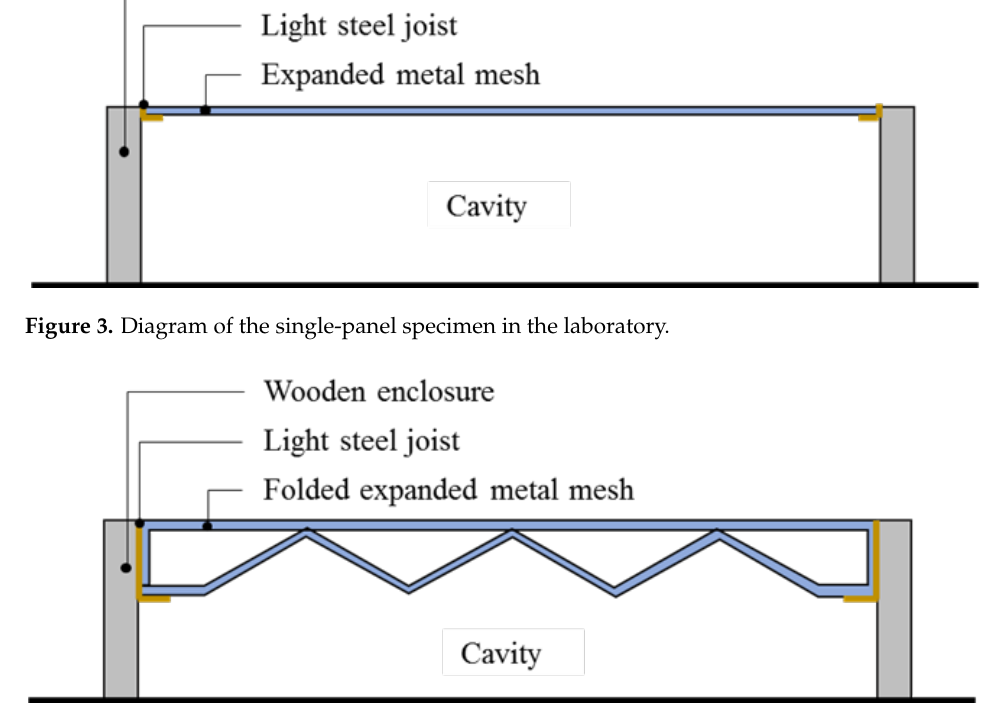
Figure 4. Diagram of the FEMM specimen in the laboratory.